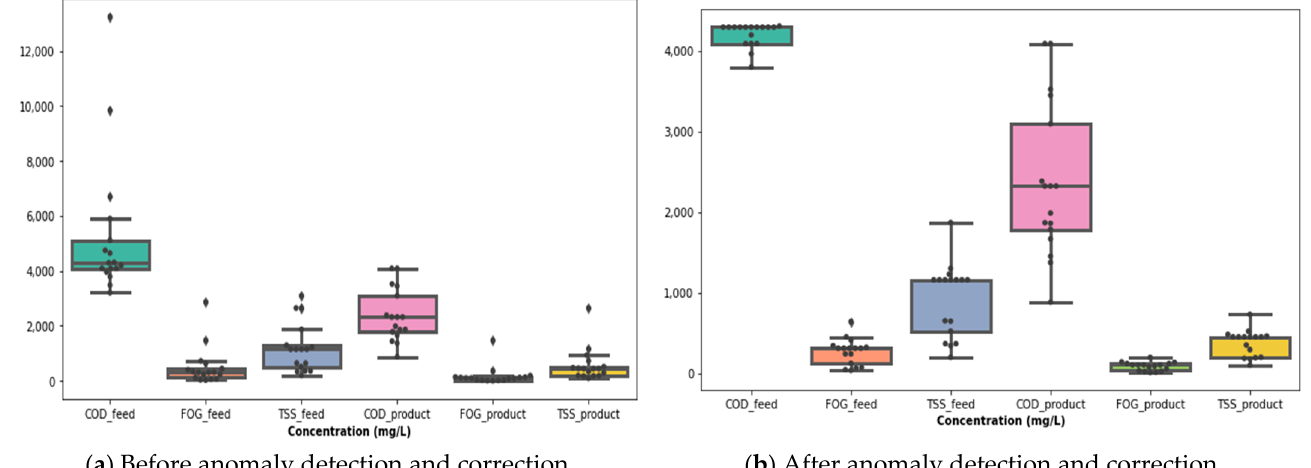
Figure 4. Boxplots of each pre ‐ treatment parameter distribution before and after anomaly detection and correction.